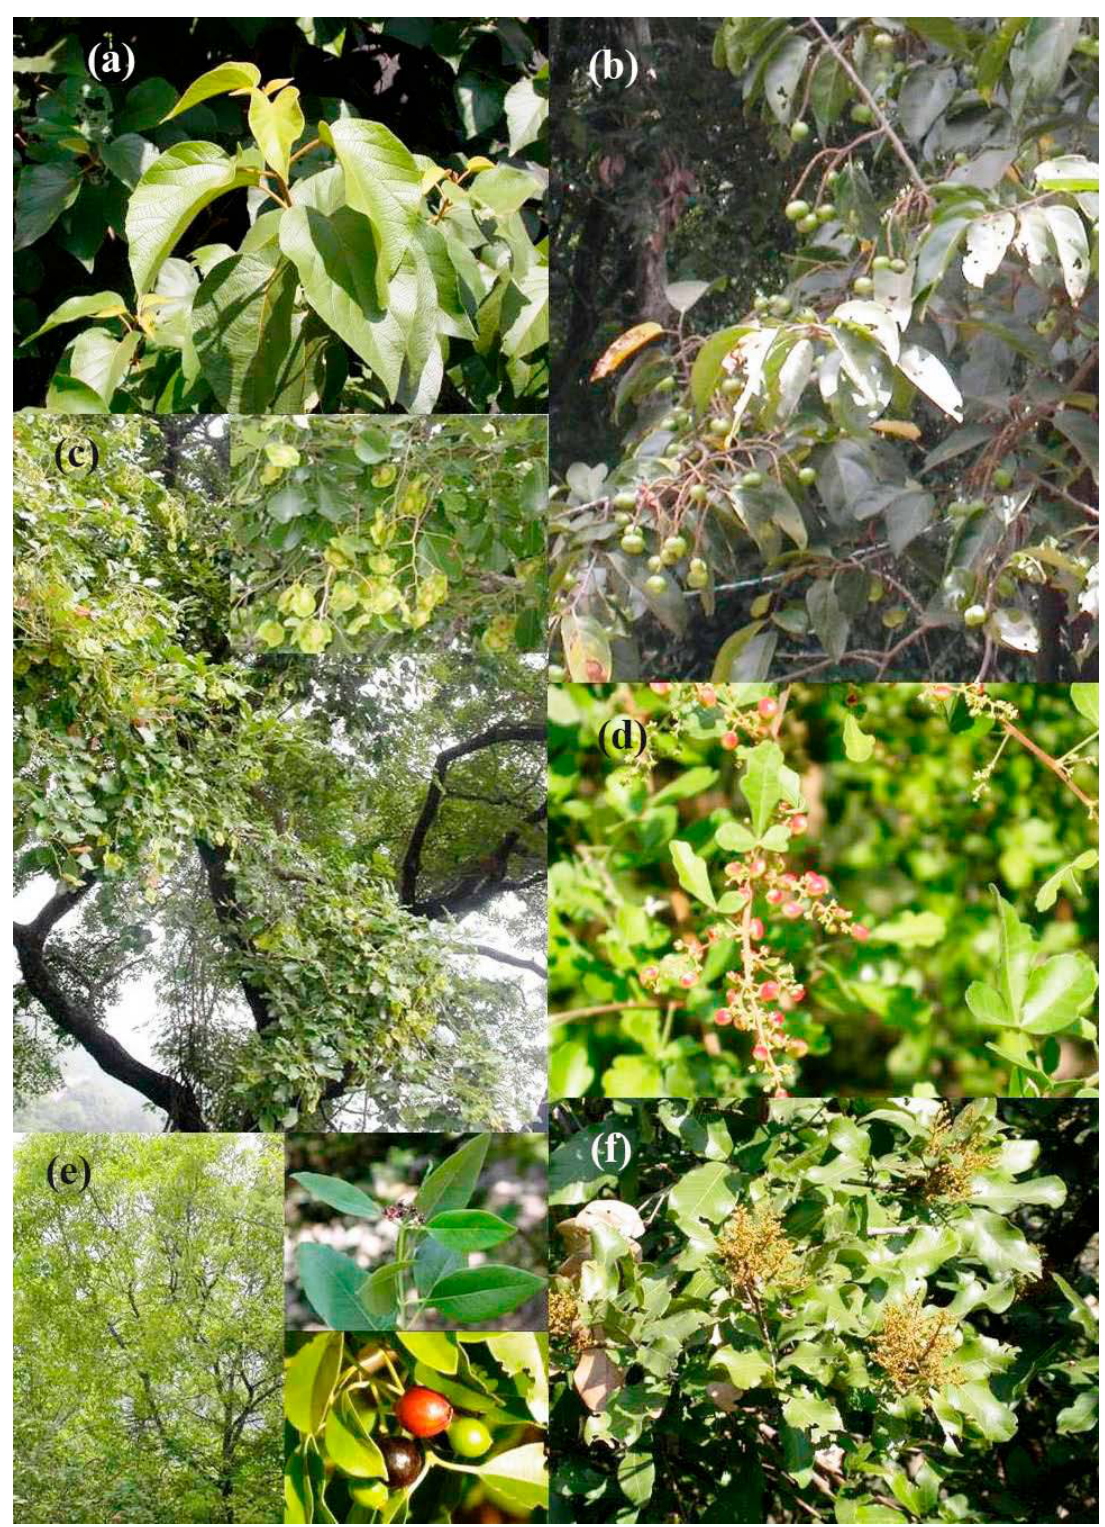
Figure 16. a) Premna tomentosa (Verbenaceae); b) Prunus ceylanica (Rosaceae); c) Pterocarpus marsupium (Papilionaceae); d) Rhus mysorensis (Anacardiaceae); e) Santalum album (Santalaceae); f) Sapindus emarginatus (Sapindaceae). Photo by L. Arul